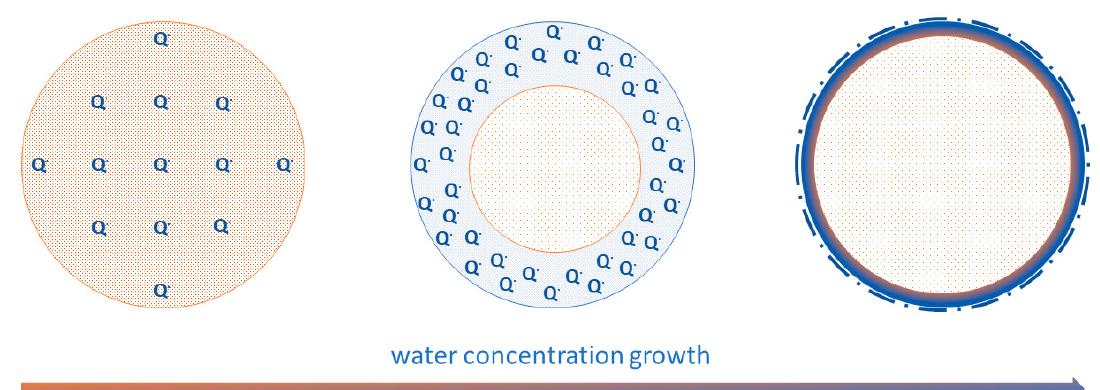
Figure 8. Redistribution of semiquinone monomers in melanin particles from the bulk to their interface caused by water concentration growth. A section of a melanin particle is shown schematically. Semiquinone monomers are shown in blue. The oxidized monomer matrix is shown in light brown.